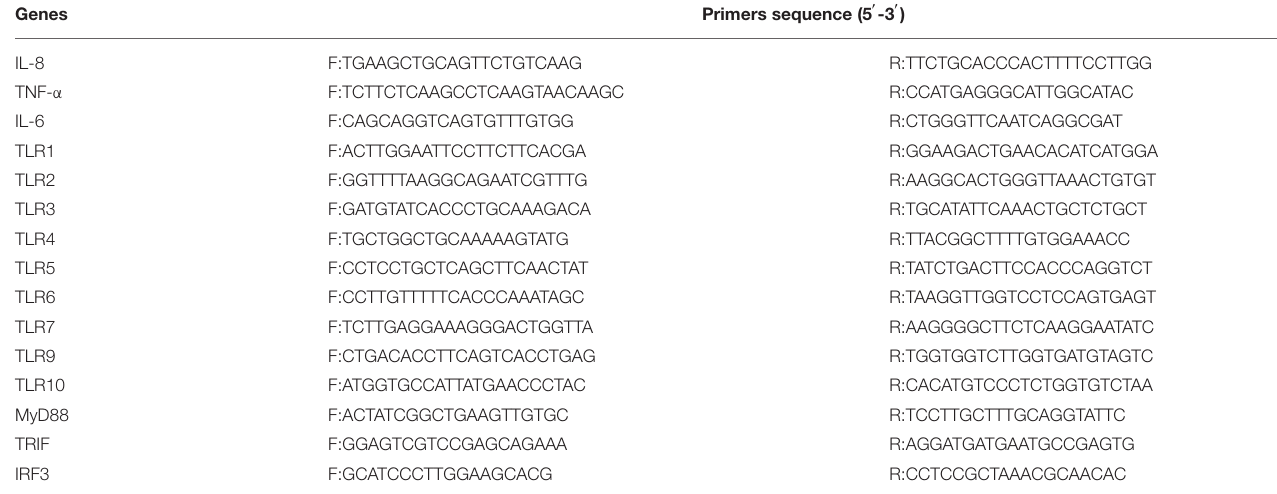
TABLE 1 | Primer sequences of fluorescence quantitative PCR. Genes Primers sequence (5 ′ -3 ′